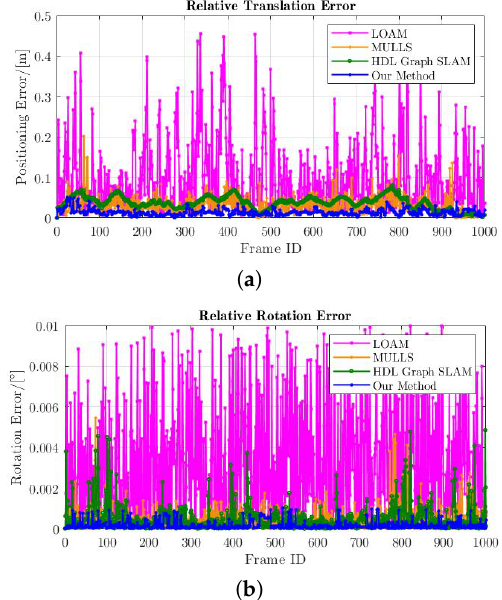
Figure 9. Relative error plots. ( a ) Relative translation error curves; ( b ) Relative rotation error curves. (NDT of HDL-Graph-SLAM, feature-based registration approach of LOAM, the proposed intensity- based registration